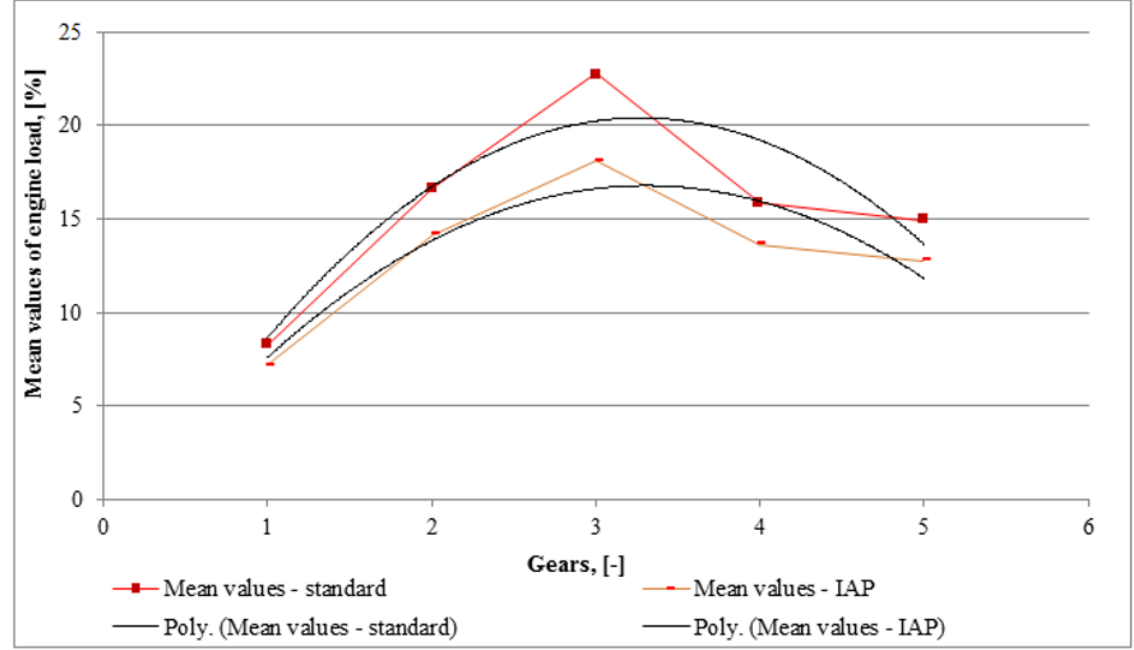
Figure 9. Engine load mean values for each gear selection.